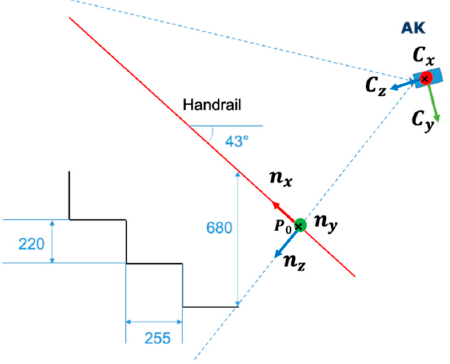
Figure 2. Stair coordinate system for Environment 1.